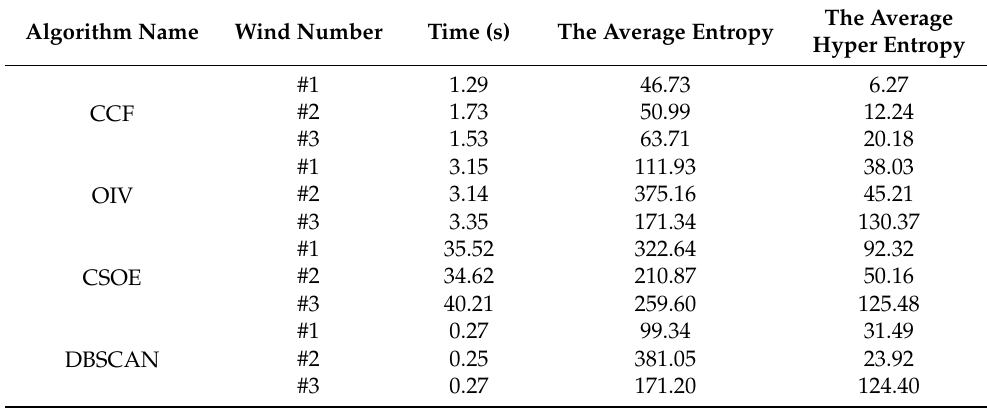
Table 3. Algorithm